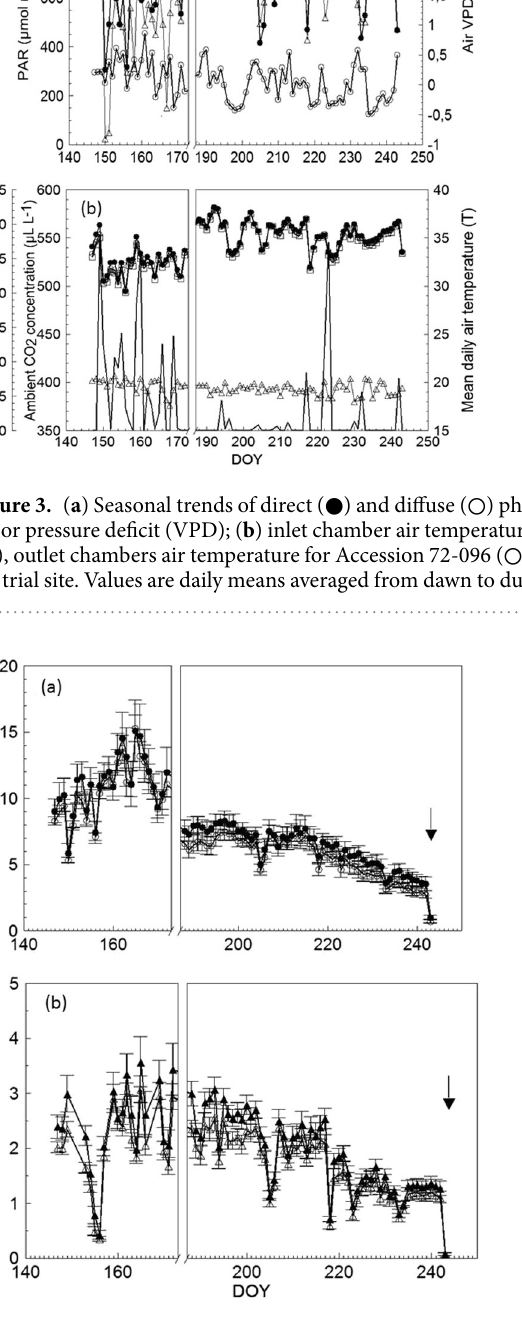
Figure 4. ( a ) Seasonal trends of daily mean net CO 2 exchange rate per unit leaf area (NCER/LA) measured in 72-096 ( ● ) and PS-SG ( ○ ) and ( b ) seasonal trends of whole-canopy transpiration per unit leaf area (T c /LA) measured on 72-096 (&#x25B4;) and PS-SG ( ▵ ). Vertical bars indicate standard error (n = 6). Arrow indicates harvest